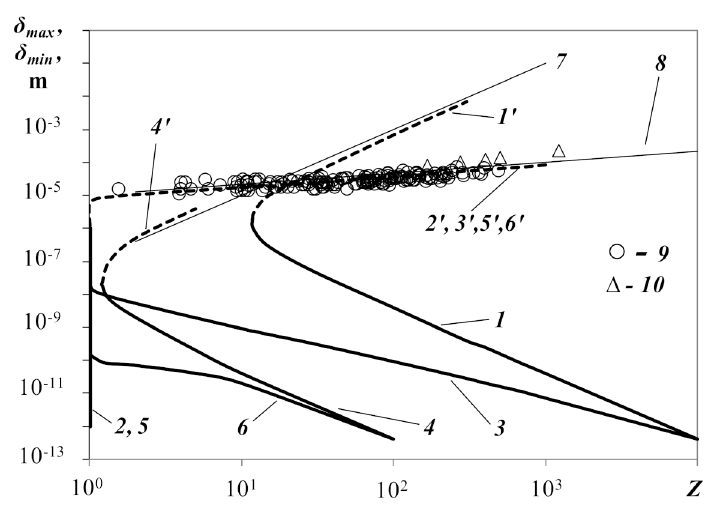
Figure 4. Distances between droplet surfaces δ max and δ min , respectively, at points of maximum and minimum free energies of a droplet (curves 1 (cid:48) , 1 ), positive ion ( 2 (cid:48) , 2 ) and all charge carriers ( 3 (cid:48) , 3 ), subject to droplet charge Z with its radius R − z = 10 − 6 m. Curves ( 4 (cid:48) , 4 ), ( 5 (cid:48) , 5 ) and ( 6 (cid:48) , 6 ) are similar curves for droplet radius R − z = 10 − 8 m. T − i = 5000 K, T − z = T +i = 300 K, χ = 0.01. 7 , 8 are approximation curves, 9 are data on droplet structures in water fog and 10 are experimental data on droplet clusters in water